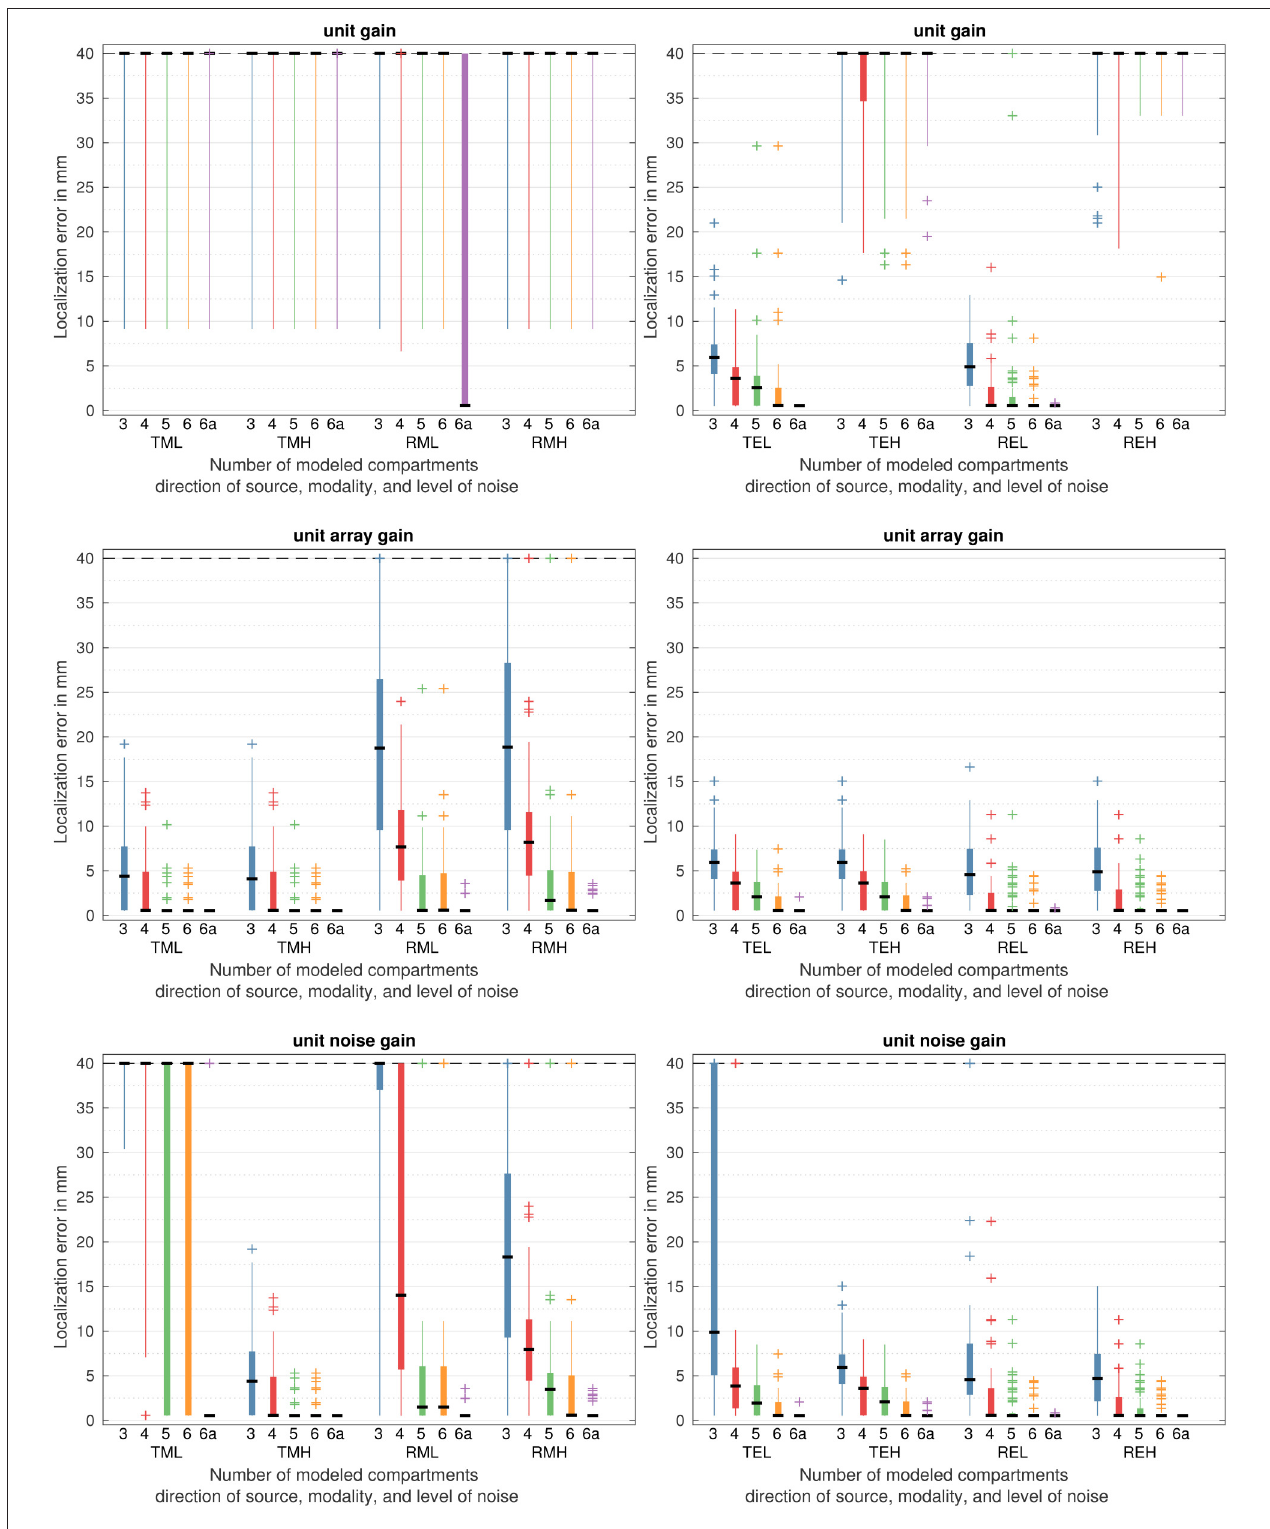
FIGURE 5 | Localization errors based on the variance beamformers output for all head models. On the left side for MEG, right side for EEG. T for quasi-tangential, R for quasi-radial sources. L for low noise, H for high noise, M for MEG simulation, E for EEG simulation. Please refer to Table 1 for an overview of the models.